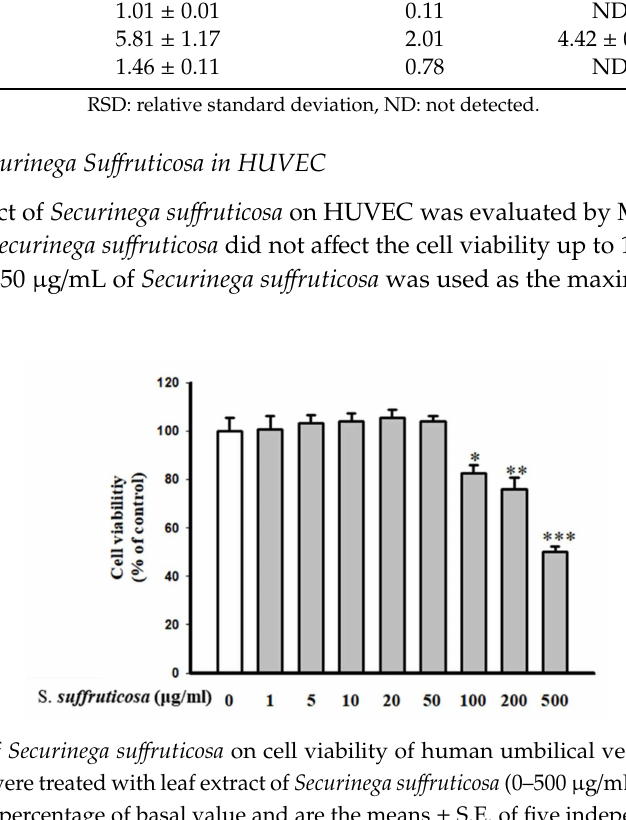
Table 2. Amount of the 7 marker components in leaves and twigs of Securinega su ff ruticosa ( n = 3). Leaves Twigs Compound Mean (mg / g) ± SD ( × 10 − 1 )